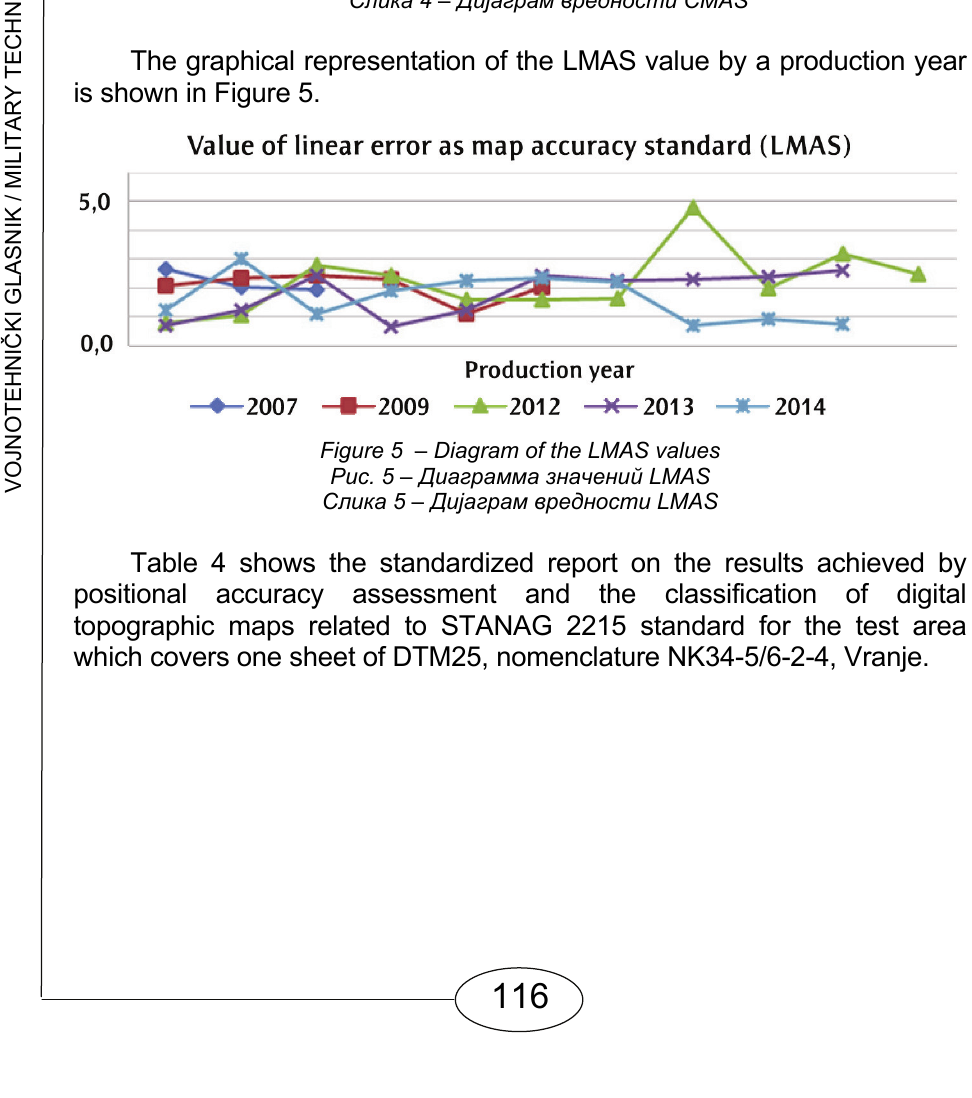
Figure 4 – Diagram of the CMAS values Рис . 4 – Диаграмма значений CMAS Слика 4 – Дијаграм вредности CMAS